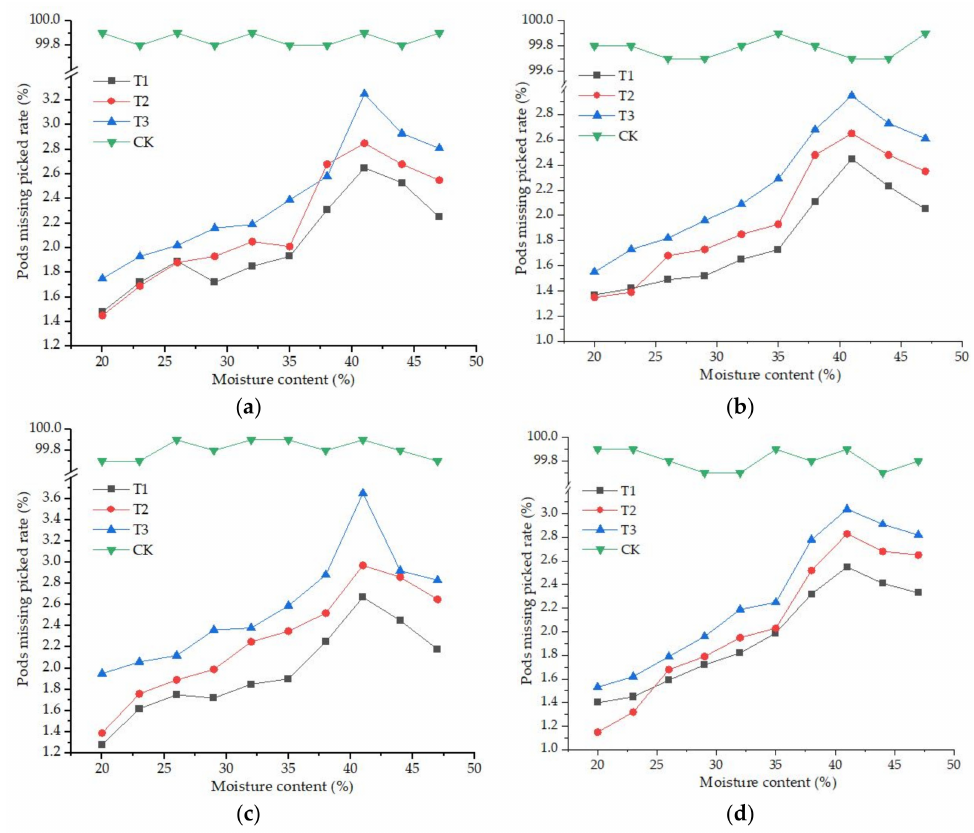
Figure 8. Test curve of missed-pickup rate of two kinds of peanuts in 2021: ( a ) 2020 Shanhua